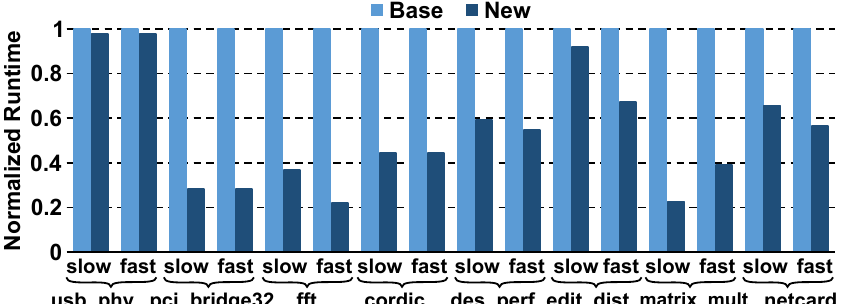
Figure 5. Runtime of both methods under comparison for all benchmarks when considering only one corner. Runtime is normalized to runtime of “Base” run. In all cases, “New” allows faster convergence saving up to 45% execution time on average in single corner benchmarks.